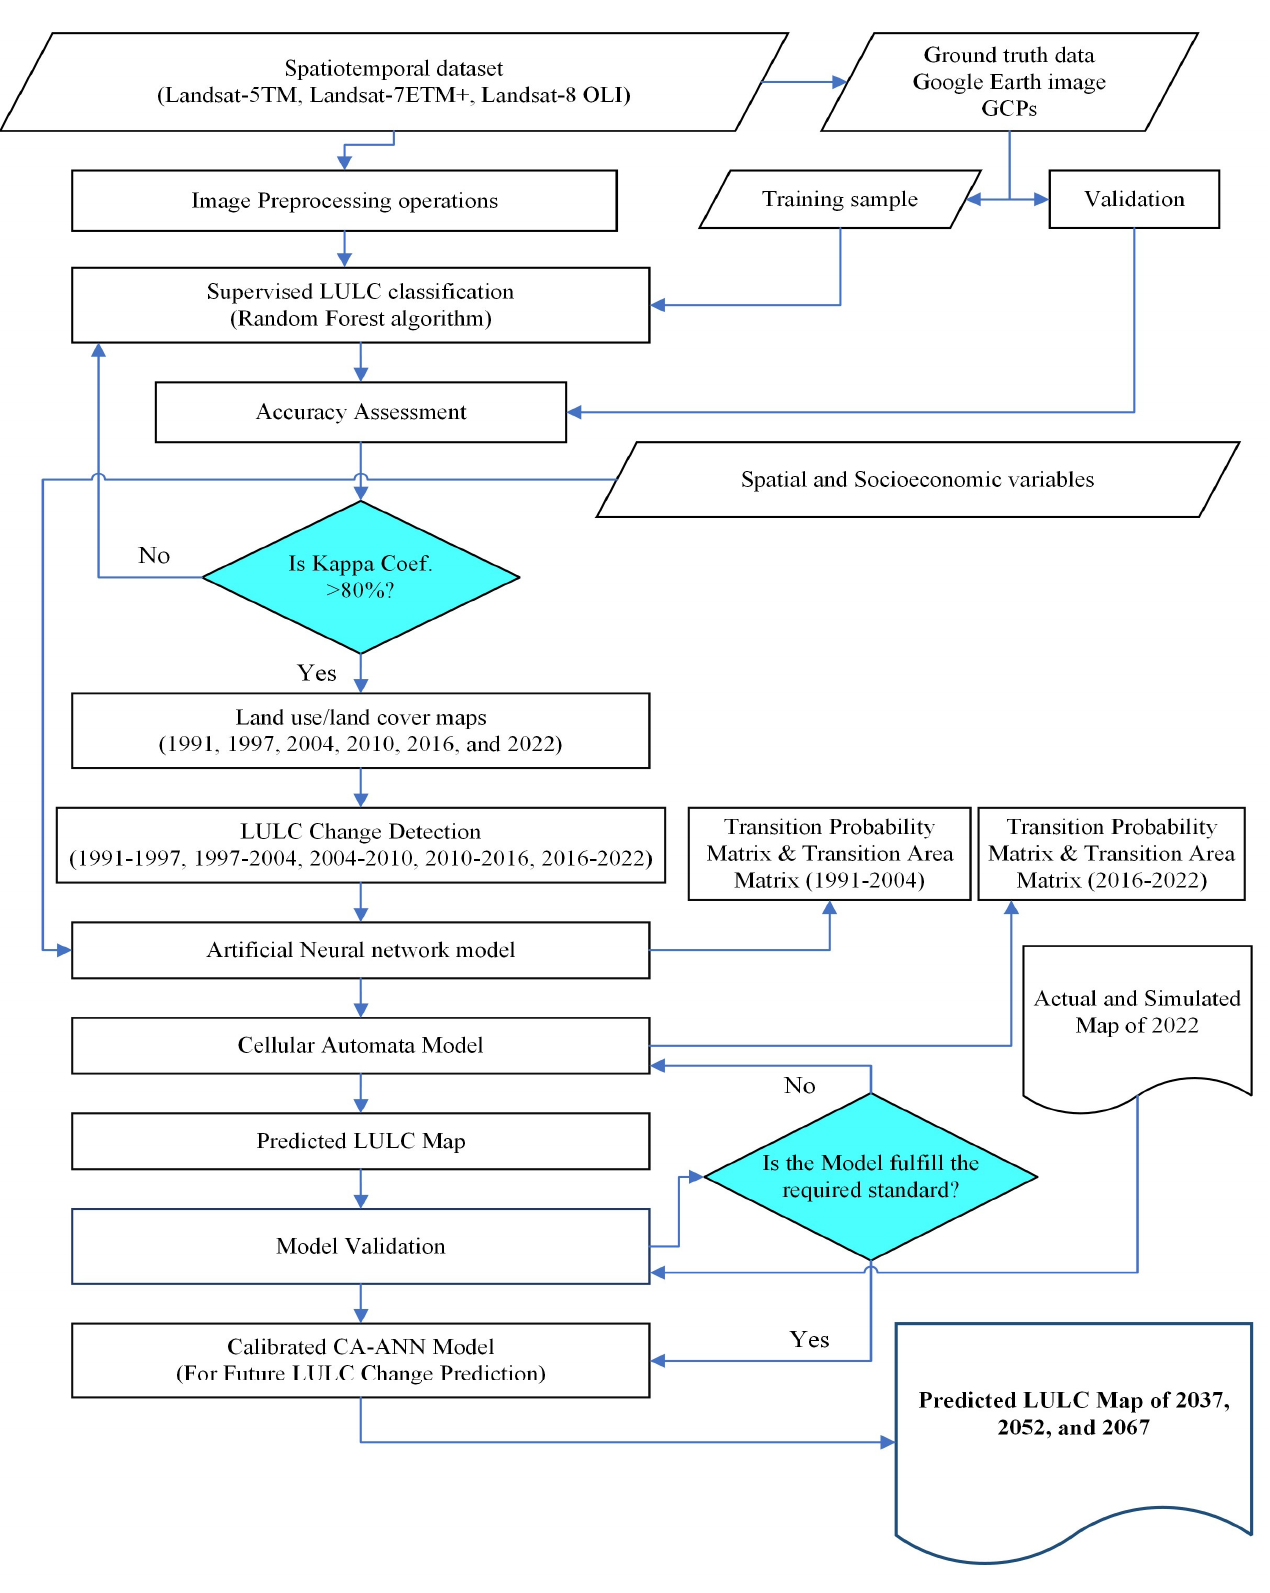
Figure 2. General flowchart of LULC change detection and prediction using the CA–ANN transition probability model (adopted from [47]).